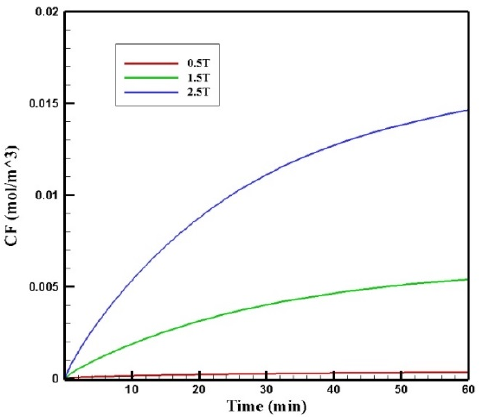
Figure 17. Comparison of the mean C F values in the tumor over 60 min of treatment for different values of magnetic strengths.